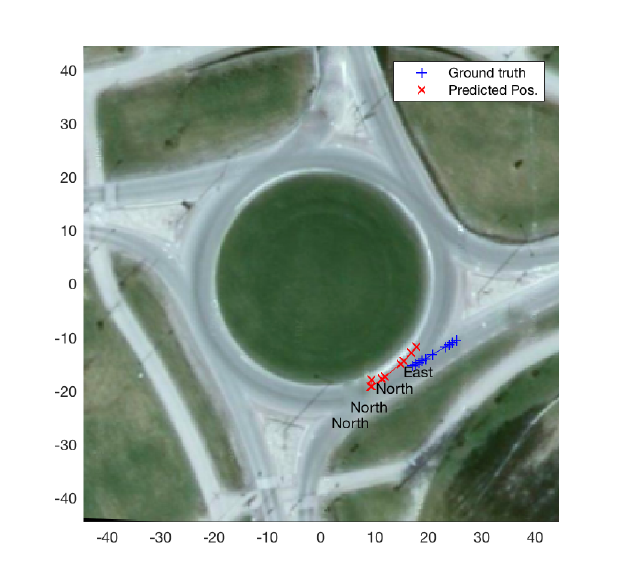
Figure 11. An instance with high mean error of 8.04 m. Primary cause for high error in state prediction is erroneous exit-direction